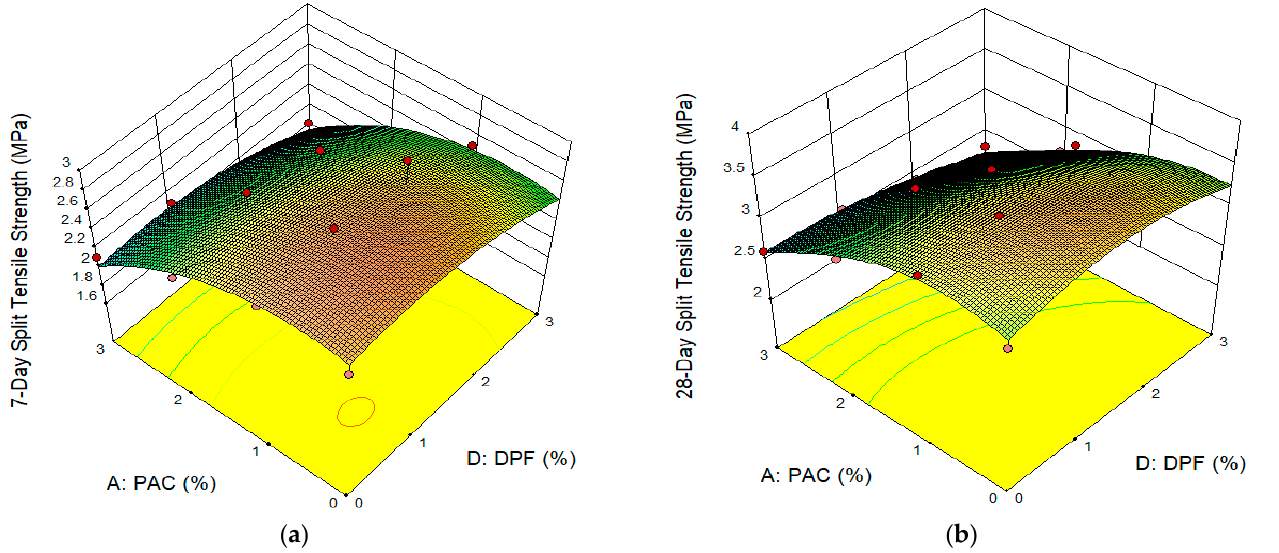
Figure 8 . Surface Plots for spli tt ing tensile strength. ( a ) 7-day Split Tensile Strength, ( b ) 28-day Figure 8. Surface Plots for splitting tensile strength. ( a ) 7-day Split Tensile Strength, ( b ) 28-day Split Split Tensile Strength. Tensile